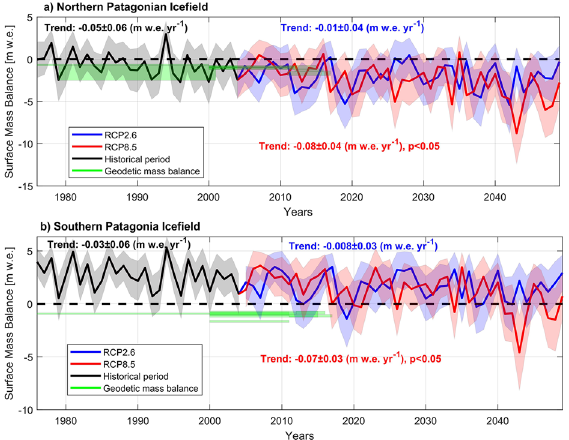
Figure 2. Time series of the modelled surface annual mass balance. ( a ) NPI and ( b ) SPI. Colour shadow represent the uncertainties in the modelled SMB for the historical period and the two scenarios. This shadow area is due to the parametrization of the glacier cooling effect and the method used for the phase partitioning in the total precipitation to define the surface snow accumulation. Green coloured bars indicate previously derived geodetic mass balances and their error range previously estimated in NPI 3,4,6,8–12 and in the SPI 3,5,7,9–12 . Trends with the 95% confidence interval are shown. Significant trends are also indicated when p <